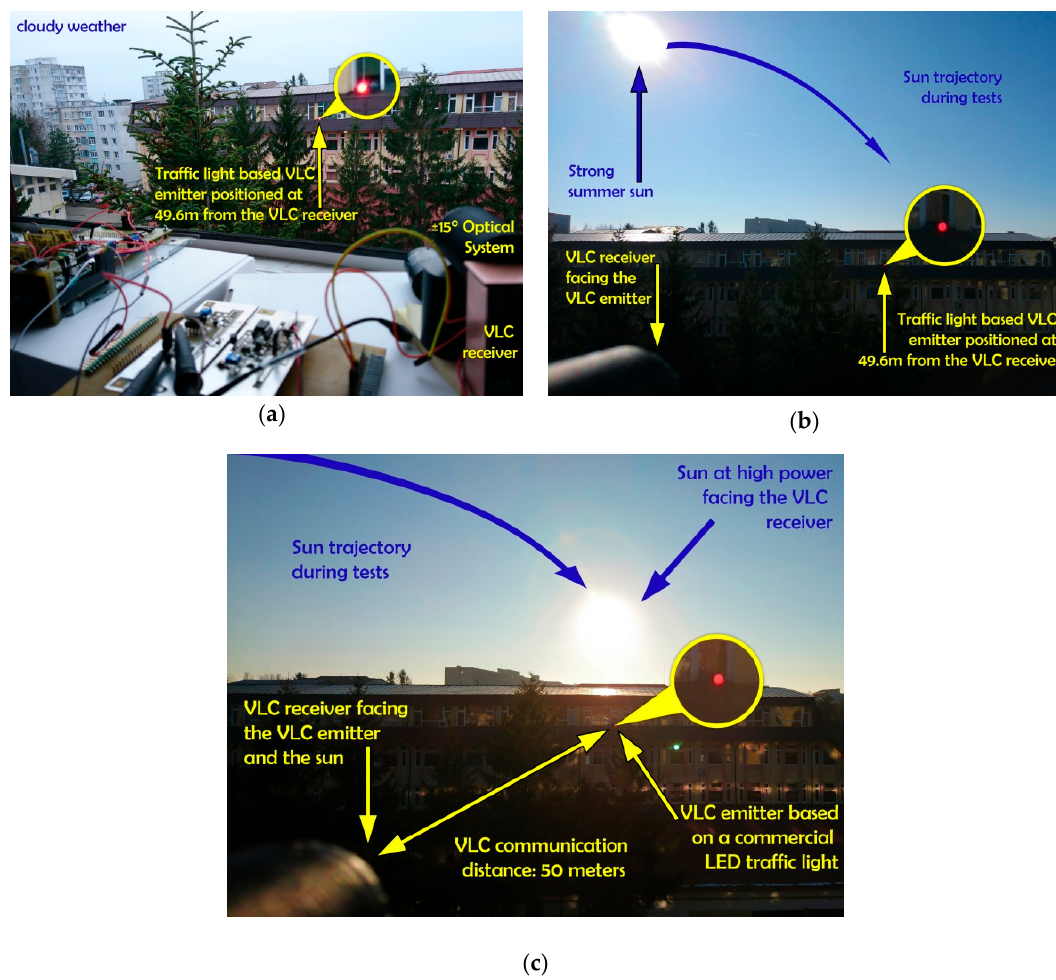
Figure 7. Picture showing the experimental setup for the 50 m VLC tests: ( a ) outdoor tests performed in moderate background lighting conditions; ( b ) strong sunlight conditions with the sun positioned left of the VLC receiver; ( c ) VLC evaluation in strong sunlight conditions: The VLC receiver is facing the LED traffic light VLC emitter. The positions of the VLC emitter and of the VLC receiver are static whereas the sun position is changing. During the afternoon, the sun is directly facing the VLC receiver.